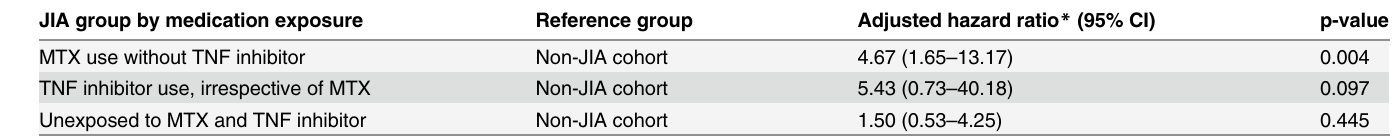
Table 3. Hazard ratios for tuberculosis infection